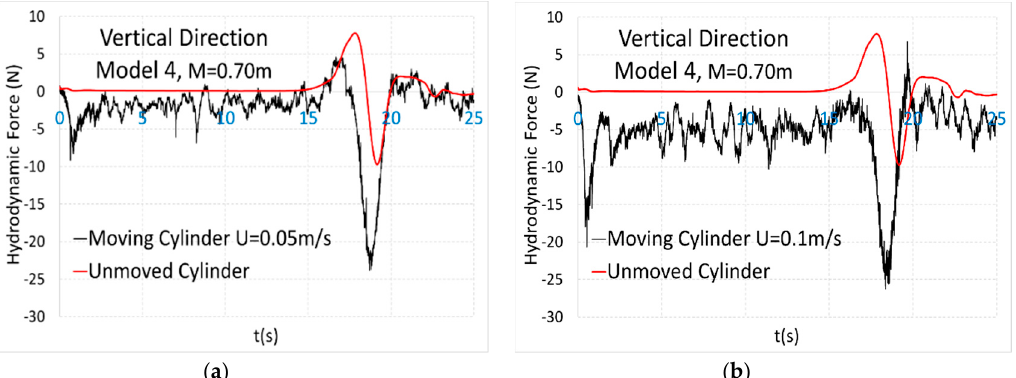
Figure 22. The time variation of the hydrodynamic forces for model 4. ( a ) The comparison between the unmoved cylinder (red line) and the moving cylinder at U c = 0.05 m/s. ( b ) The comparison between the unmoved cylinder (red line) and the moving cylinder at U c = 0.1 m/s.